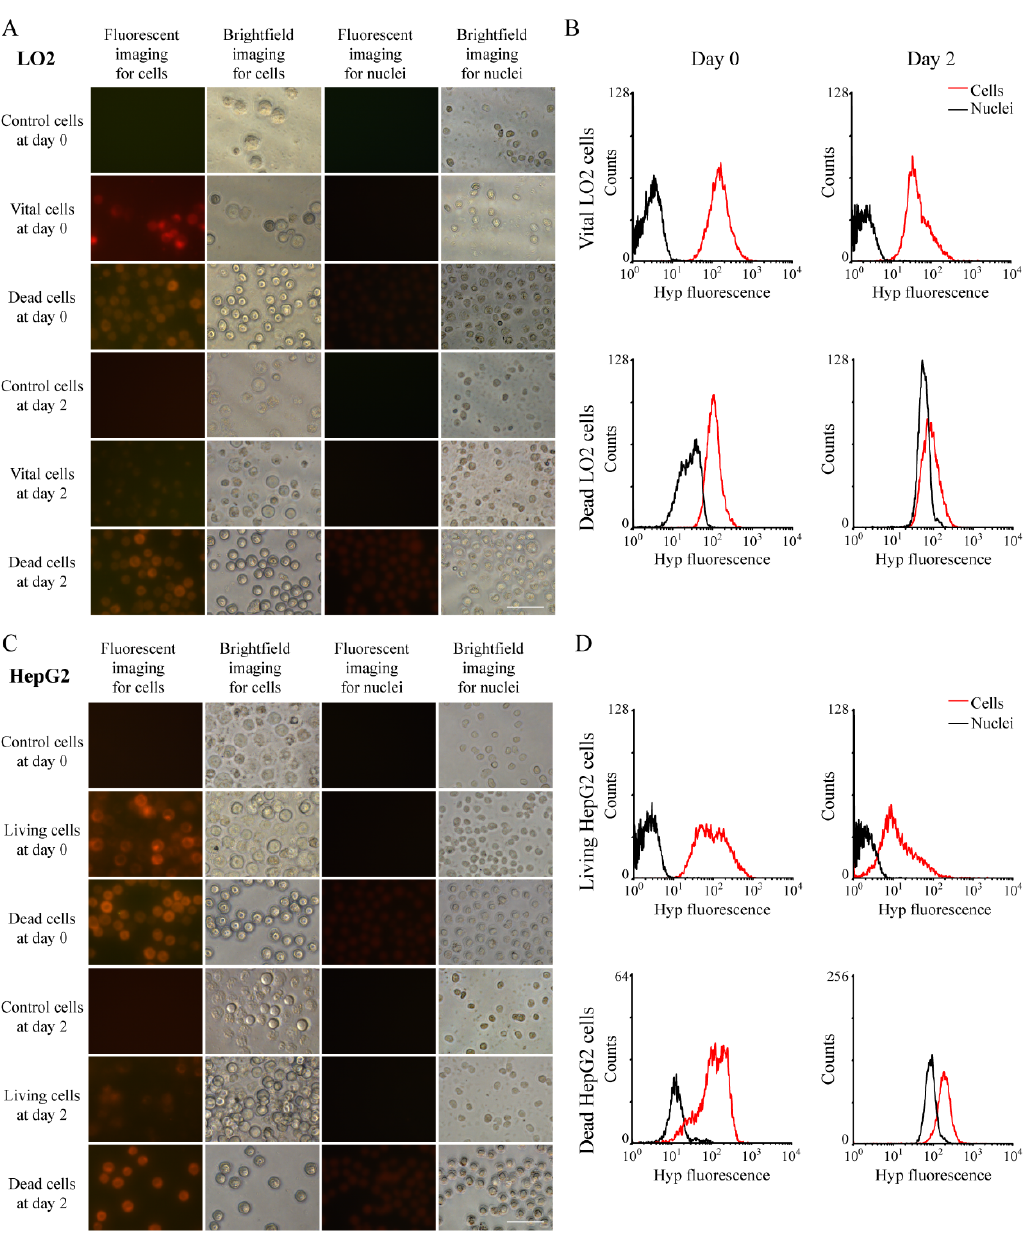
Figure 3. Hyp concertation in cells and paired nuclei: ( A ) Hyp fluorescence under ultraviolet light or white light of LO2 cells or nuclei extracted from paired cells. Scale bar = 50 µ m. ( B ) Measurement of Hyp concentration in LO2 cells and their nuclei by flow cytometry. ( C ) Hyp fluorescence under ultraviolet light or white light of HepG2 cells or nuclei extracted from paired cells. Scale bar = 50 µ m. ( D ) Measurement of Hyp concentration in HepG2 cells and their nuclei by flow cytometry.